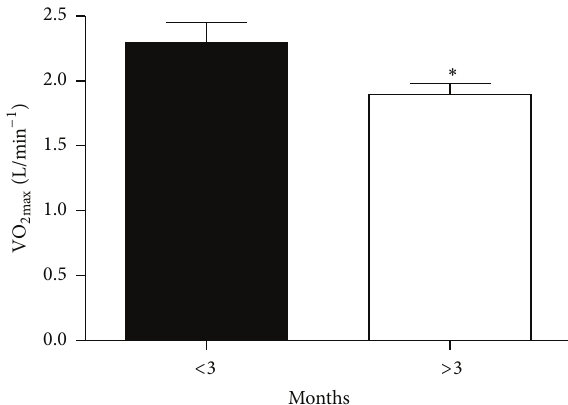
Figure 1: Absolute VO 2 max values (mean ± SE) for the short- and longer-term androgen deprivation groups. ∗ denotes significant difference versus < 3